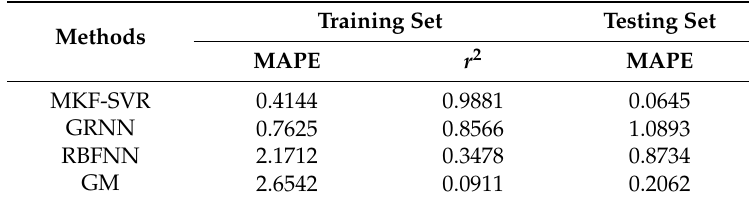
Table 7. The comparison of experimental results for H 2 (Case 1).